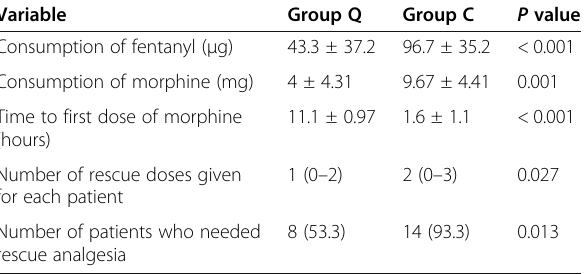
Table 5 Comparison for narcotic consumption intra- and postoperative between the Q group and the C group